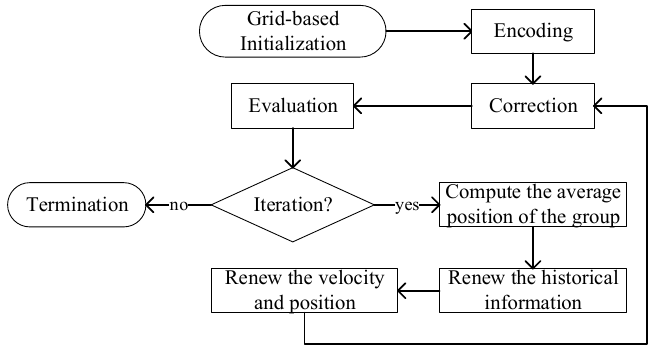
Figure 4. The flow chart of MPSO.